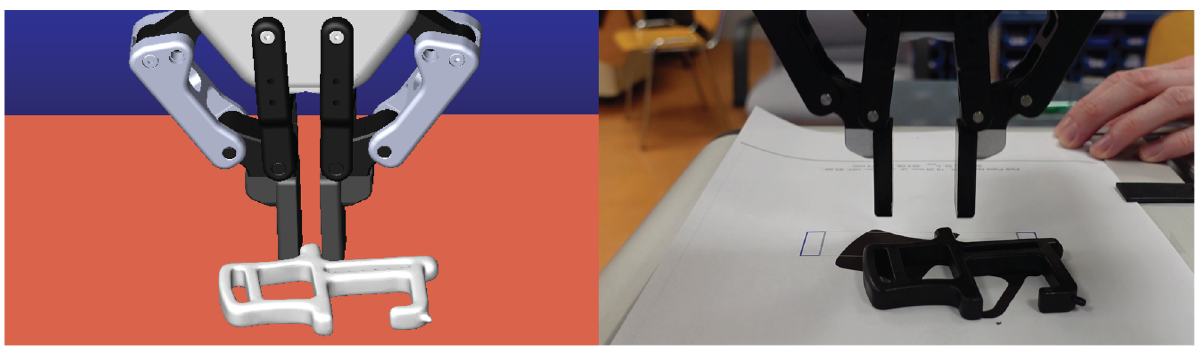
Figure 14. Graphical analysis of the first pick-point. Source: own.